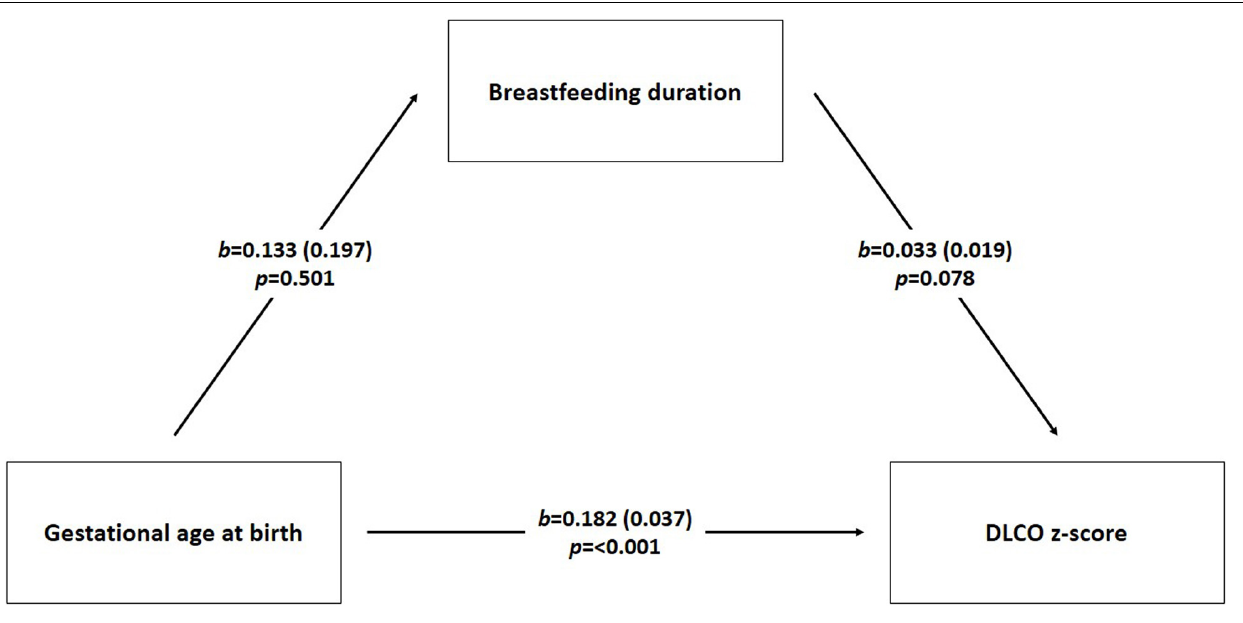
FIGURE 2 | Mediation analysis scheme. We performed mediation analysis using linear regression to investigate the interrelationship of three numeric variables DLCO z score (diffusing lung capacity) as dependent variable, breastfeeding duration (months) as mediator, and gestational age at birth (weeks) as independent variable. The model was also adjusted for gender, smoking during pregnancy, twins, and mode of delivery. b is the regression coefficient; p -value was considered significant <